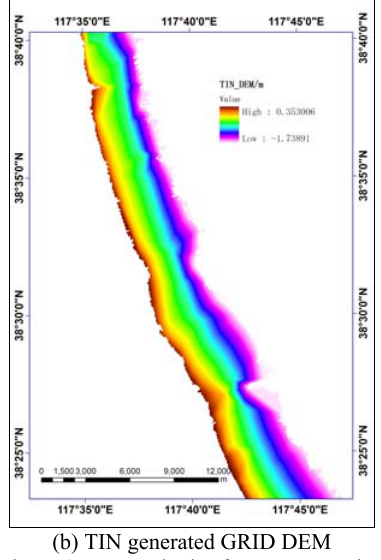
Figure.8 Two methods of DEM generating Two DEMs of different intervals were built by this approach and were compared to evaluate the morph-dynamics of mudflats (Figure.8). TIN and Kriging interpolated methods